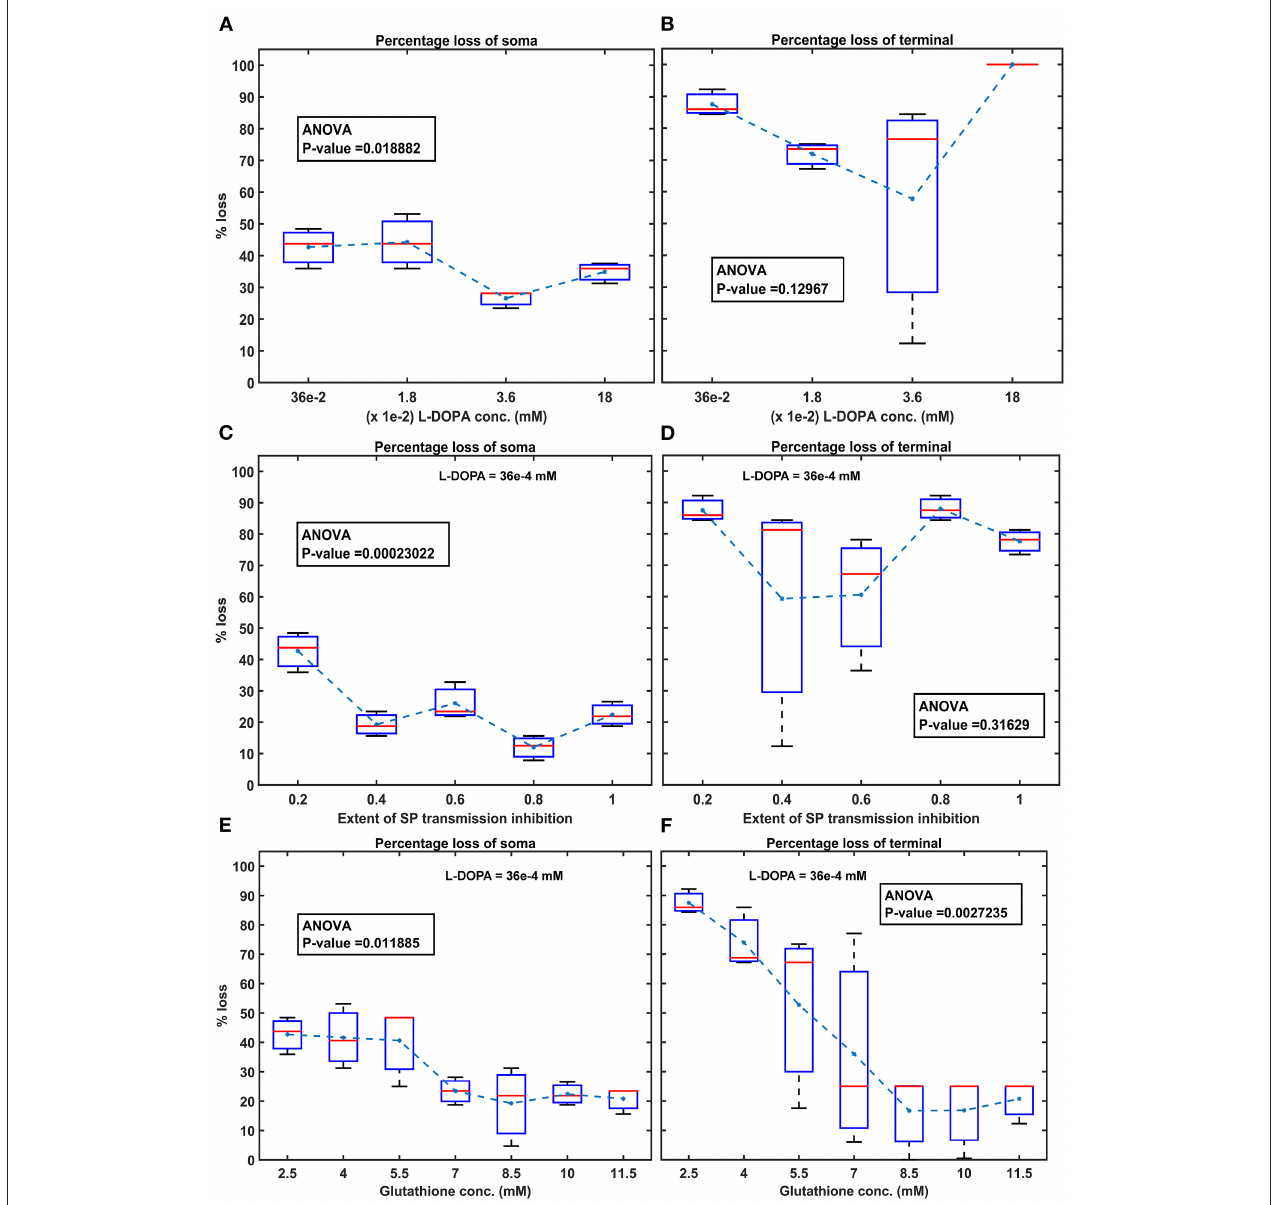
FIGURE 8 | Model response to different therapeutics under energy deficiency. (A) Percentage loss of somas during L-DOPA therapy, (B) percentage loss of terminal during L-DOPA therapy, (C) percentage loss of somas during SP antagonist therapy, (D) percentage loss of terminals during SP antagonist therapy, (E) percentage loss of somas during glutathione therapy, ( F) percentage loss of terminals during glutathione therapy. All the therapeutic interventions were initiated at 25% soma or terminal loss. conc, concentration; L-DOPA, levodopa; SP, substance P; mM, millimolar; ANOVA, analysis of variance.